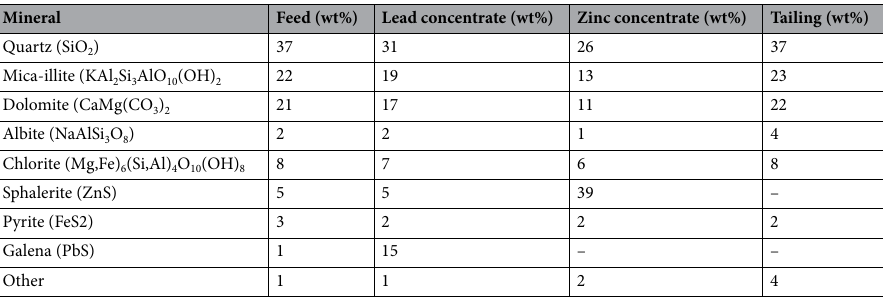
Table 2. Mineral content of flotation feed, lead and zinc concentrate, and tailing.